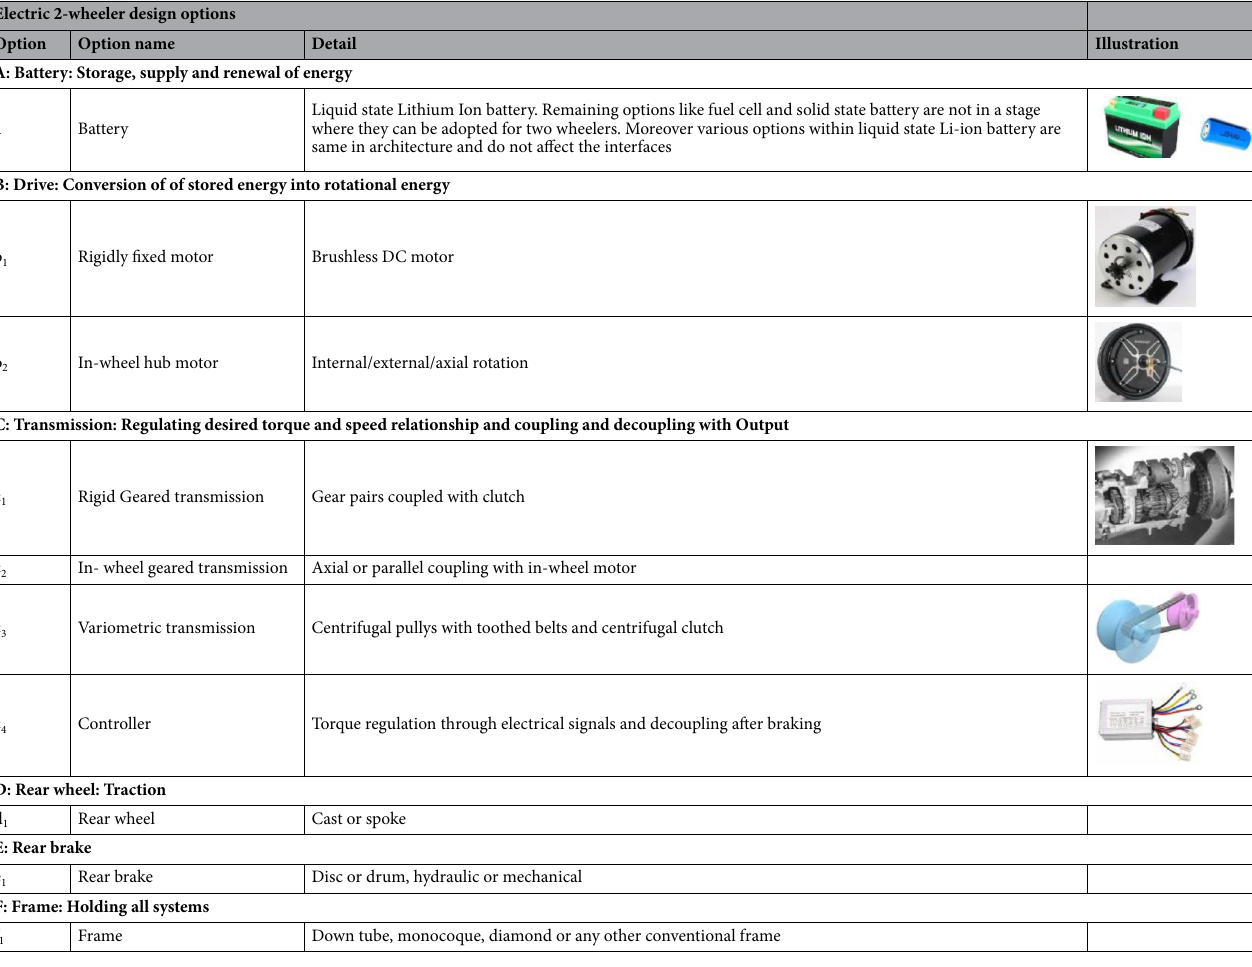
Table 17. System-wise design options for the new